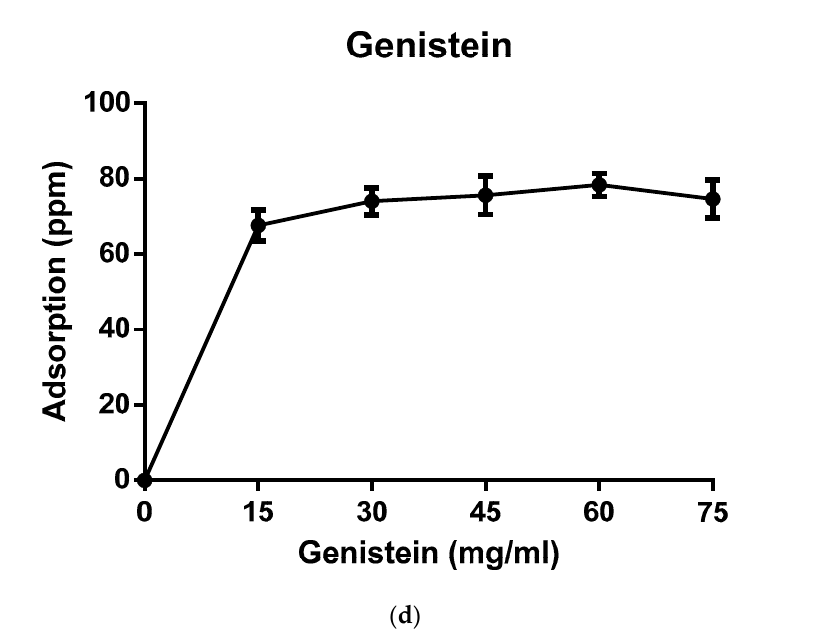
Figure 1. Effect of biopolymer contact time on the adsorption of phytoestrogens: ( a ) formononetin, ( b ) genistein, ( c ) biochanin A, and ( d ) daidzein. The error bars represent the ± SD of three replicates.